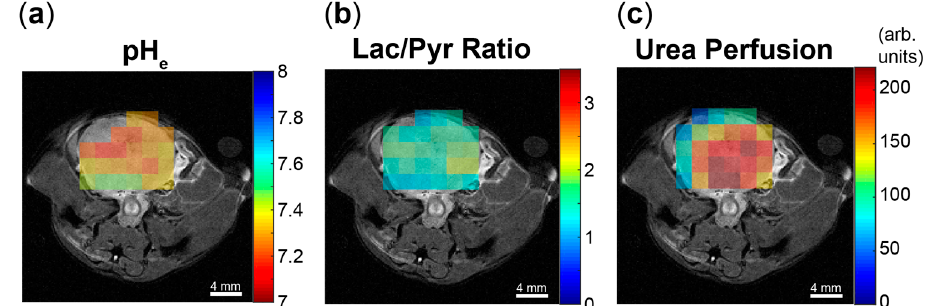
Figure 3. Hyperpolarized imaging of pH e , lactate conversion, and perfusion can be performed in a single imaging study. Data are shown for a transgenic adenocarcinoma of the mouse prostate (TRAMP) animal model displaying a consolidated, high-grade tumor confirmed with histology. HP images of ( a ) extracellular pH, ( b ) lactate-to-pyruvate (Lac / Pyr) ratio, and ( c ) urea signal intensity are shown overlaid on 1 H anatomical images, enabling voxel-to-voxel correlations in order to study the interplay between metabolism and acidification.